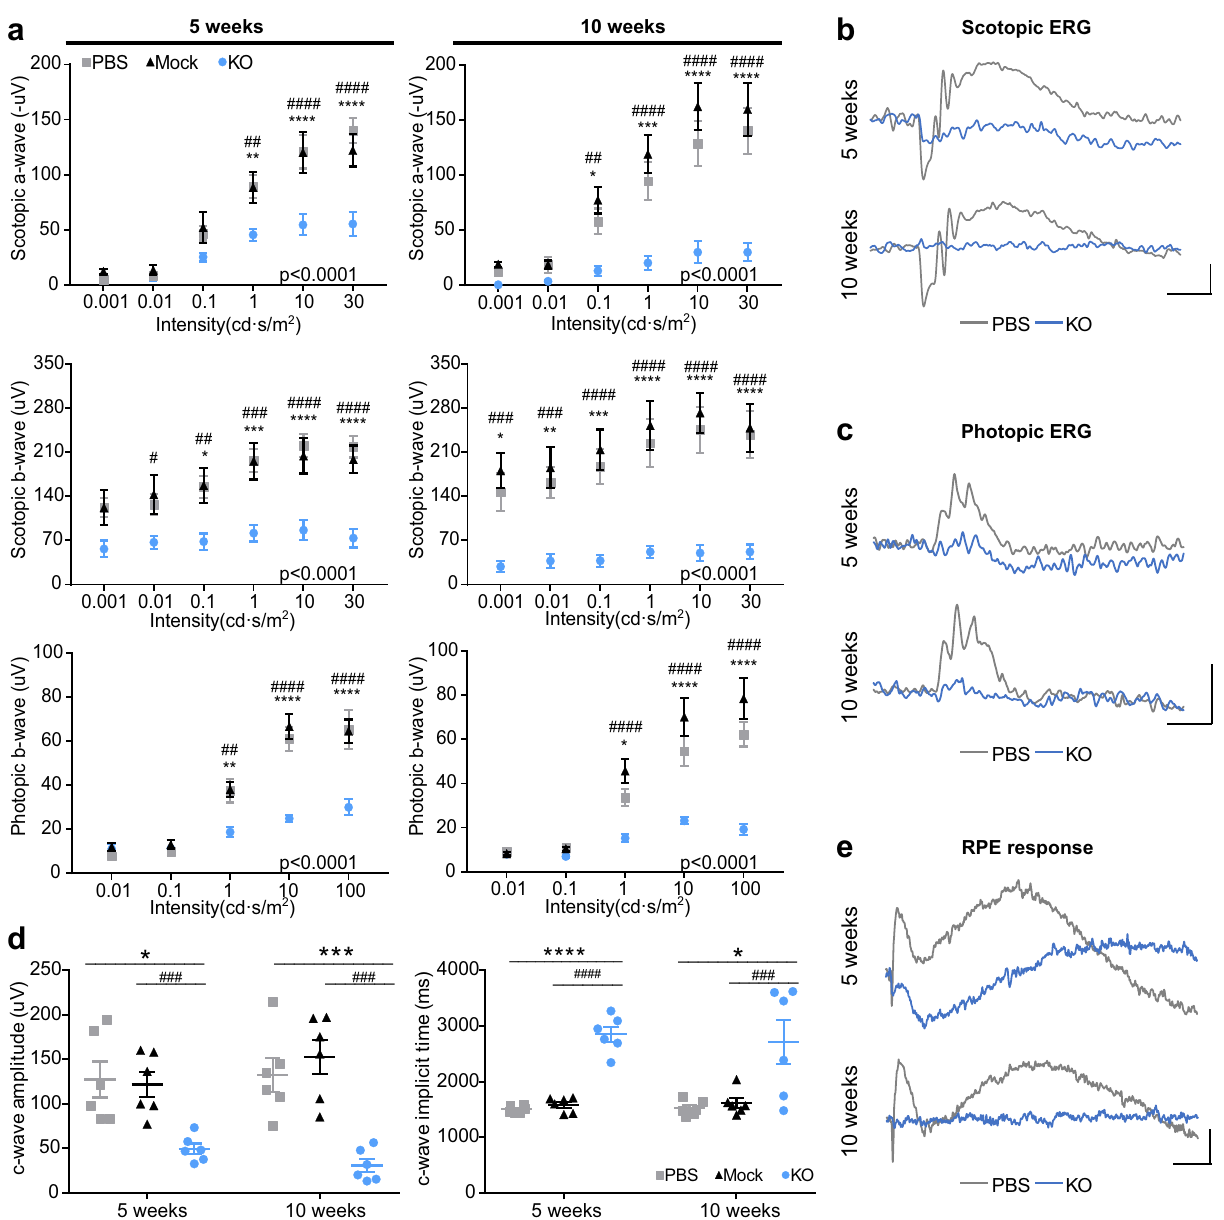
Fig. 4 | Subretinal injection of two Prpf31 -KO vectors results in severe func- tional changes in outer retina. a Quanti fi cation of ERG scotopic and photopic a- and b-wave amplitudes ( n =6). b Representative scotopic and c representative photopicERG recordings stimulated by a 10cd·s/m 2 fl ash. Scalebar vertical,50 µ V; Scale bar horizontal, 50ms. d Quanti fi cation of dark-adapted ERG c-waves ( n =6). e Representative ERG c-wave recordings. Scale bar vertical, 50 µ V; Scale bar hor- izontal, 500ms. ERGs recorded 5 weeks (p.i.), showed signi fi cantly reduced sco- topicandphotopica-waveandb-waveresponsesinKOeyesacrossawiderangeof stimulus intensities. ERG c-wave responses from KO eyes were dramatically decreasedandhadprolongedimplicittimescomparedwithPBSandmock-injected